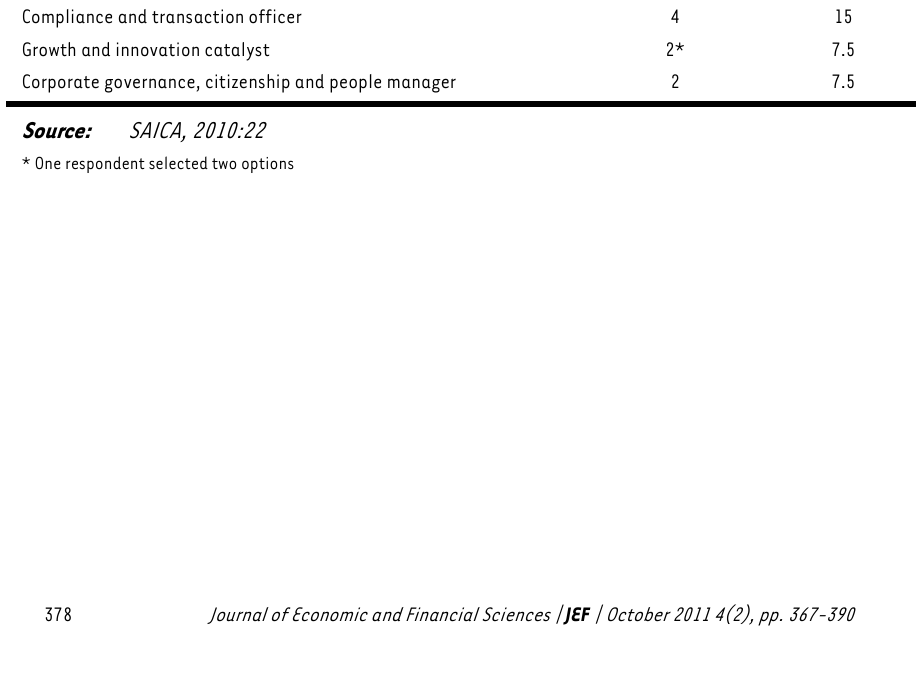
Planner and strategist 19* 70 Compliance and transaction officer 4 Growth and innovation